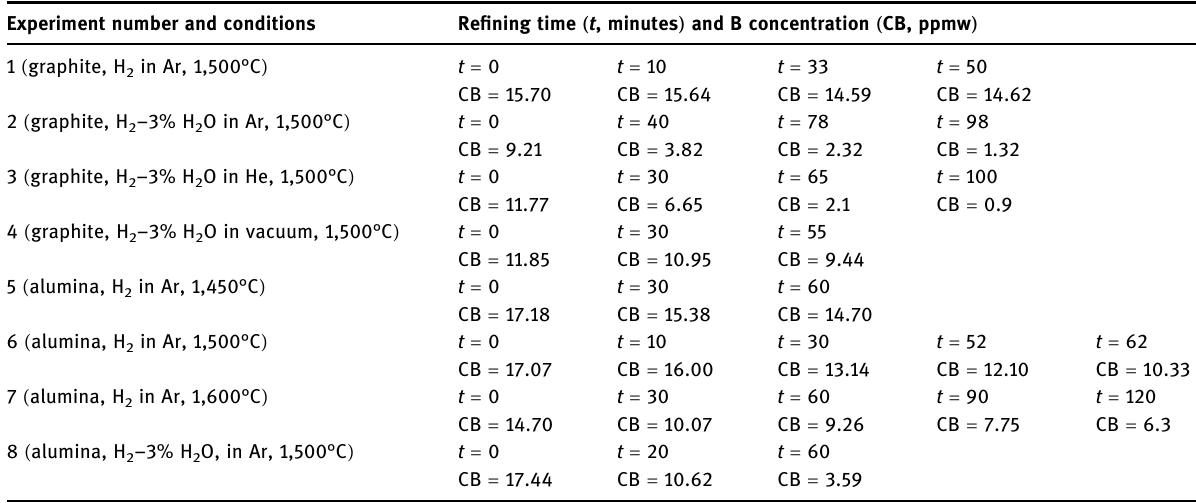
Table A1: The concentration of boron measured by ICP – MS at various times during the gas re fi